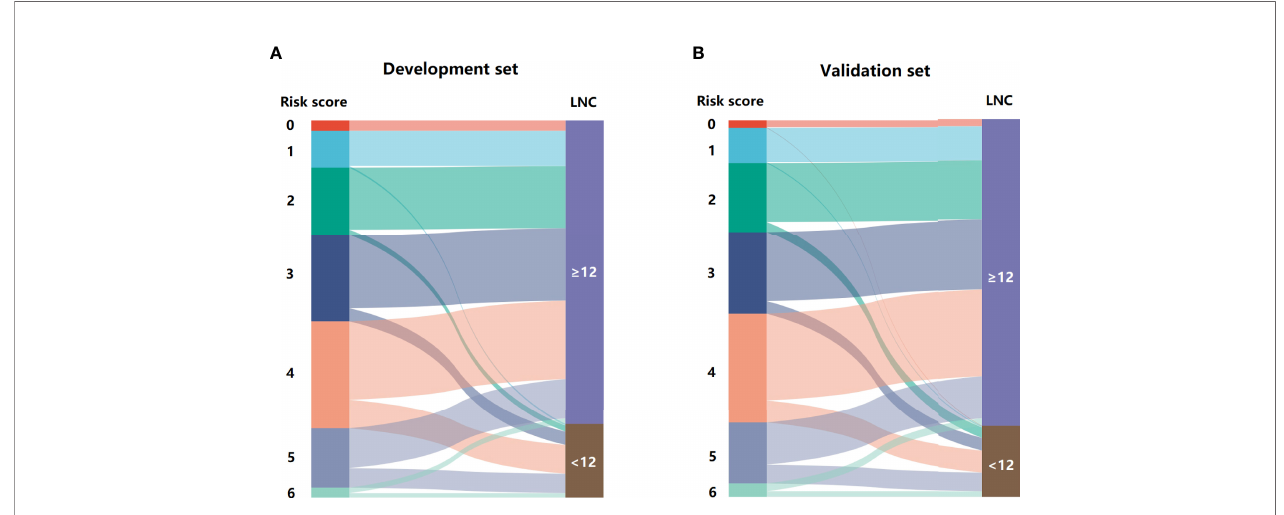
FIGURE 3 | The Sankey diagram for the proportion of LNC < 12 in patients with different risk scores. (A) development set and (B) validation